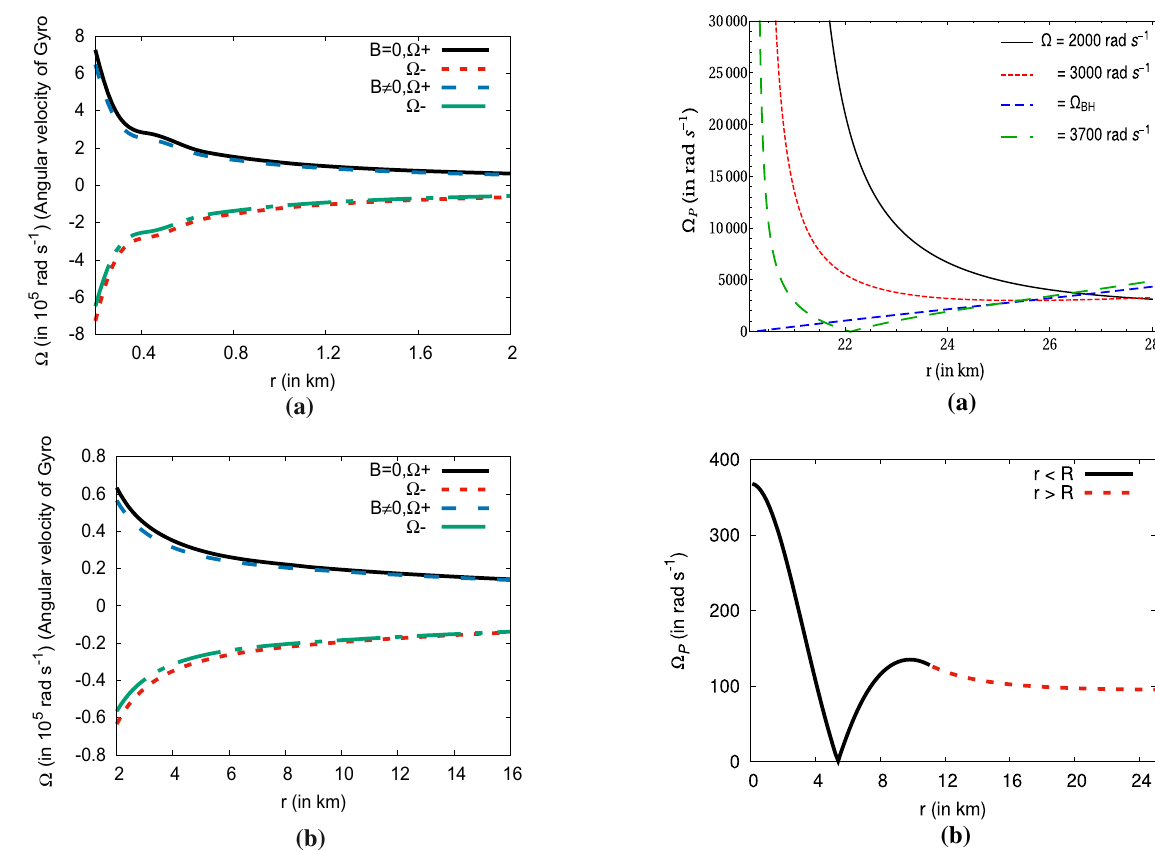
Fig. 10 a Variation of the GPF along the equatorial plane around a 8 M ◦ ( M ◦ being the solar mass and M being the mass of the BH in this case) Kerr BH ( a = 0 . 7 M ) with Ω = 2000 rad s − 1 , 3000 rad s − 1 , Ω BH and 3700 rad s − 1 is indicated by black-solid curve, red-short dashed curve, blue dashed curve and green-long dashed curve respectively. b PF along the equatorial plane around a 1 . 5 M ◦ NS ( ω = 700 rad s − 1 ) of radius ∼ 11 km with Ω = 100 rad s − 1 . The black solid curve and the red short dashed curve are for interior and exterior regions of the star